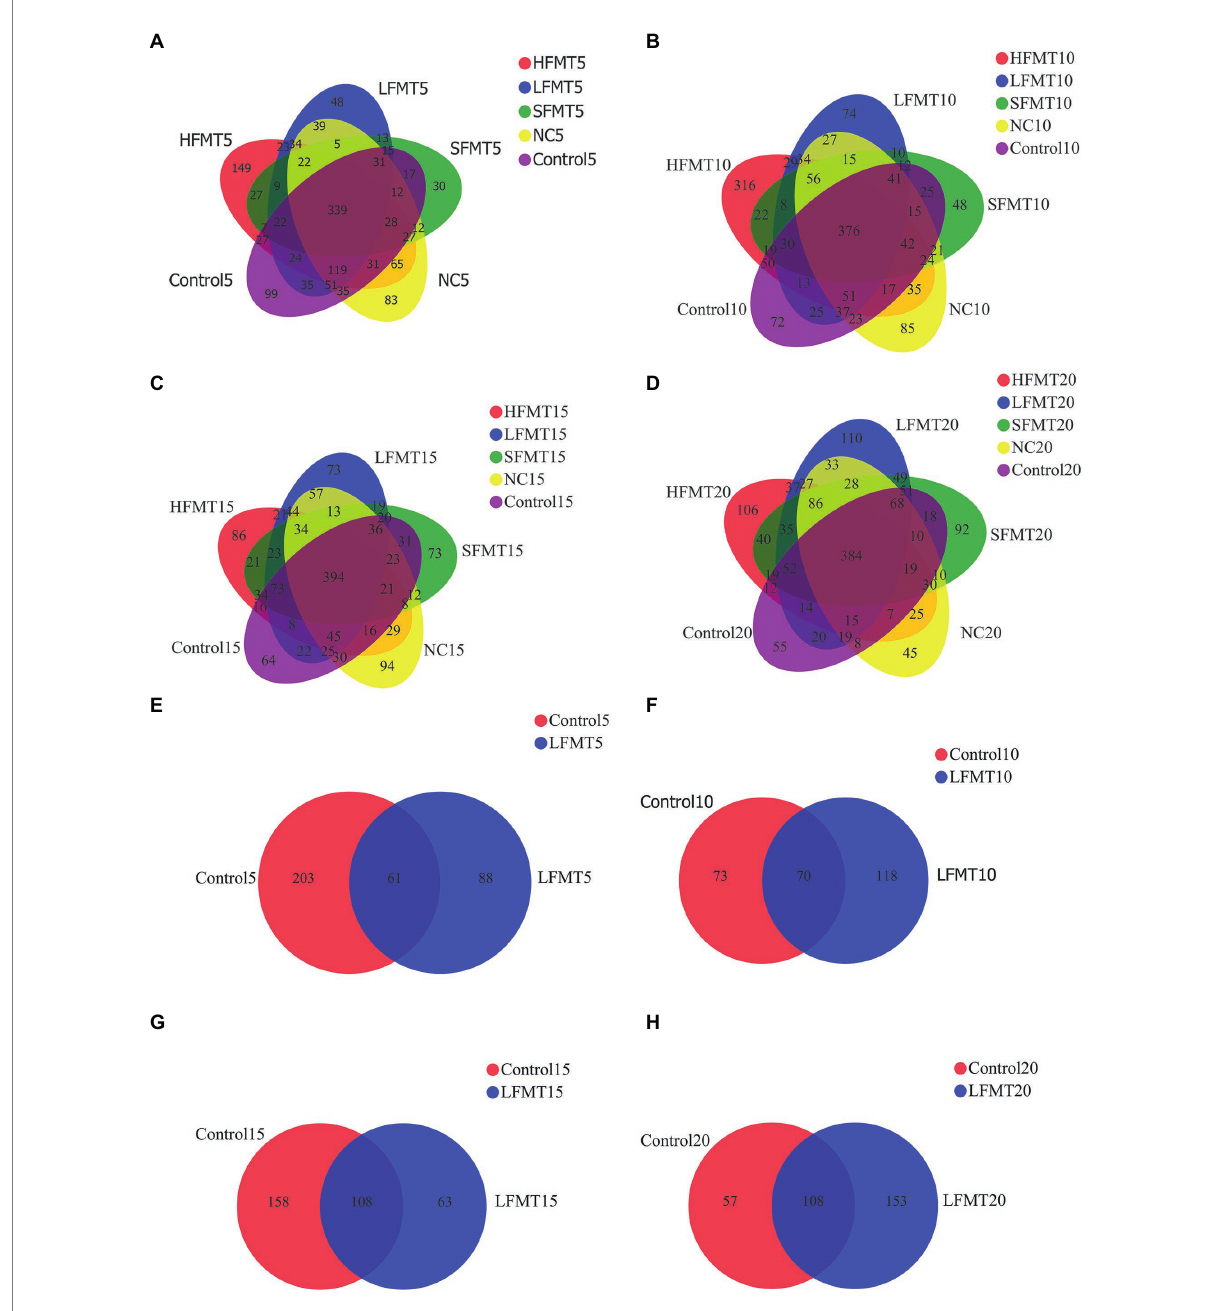
FIGURE 1 Venn diagrams were used to show the number of OTUs common or unique by bacteria and fungi at four time points after weaning of Holstein calves treated with different FMT. (A) Venn diagram of fecal bacteria on the 5th day after weaning. (B) Venn diagram of fecal bacteria on the 10th day after weaning. (C) Venn diagram of fecal bacteria on the 15th day after weaning. (D) Venn diagram of fecal bacteria on the 20th day after weaning. (E) Venn diagram of fecal fungi on the 5th day after weaning. (F) Venn diagram of fecal fungi on the 10th day after weaning. (G) Venn diagram of fecal fungi on the 15 h day after weaning. (H) Venn diagram of fecal fungi on the 20th day after